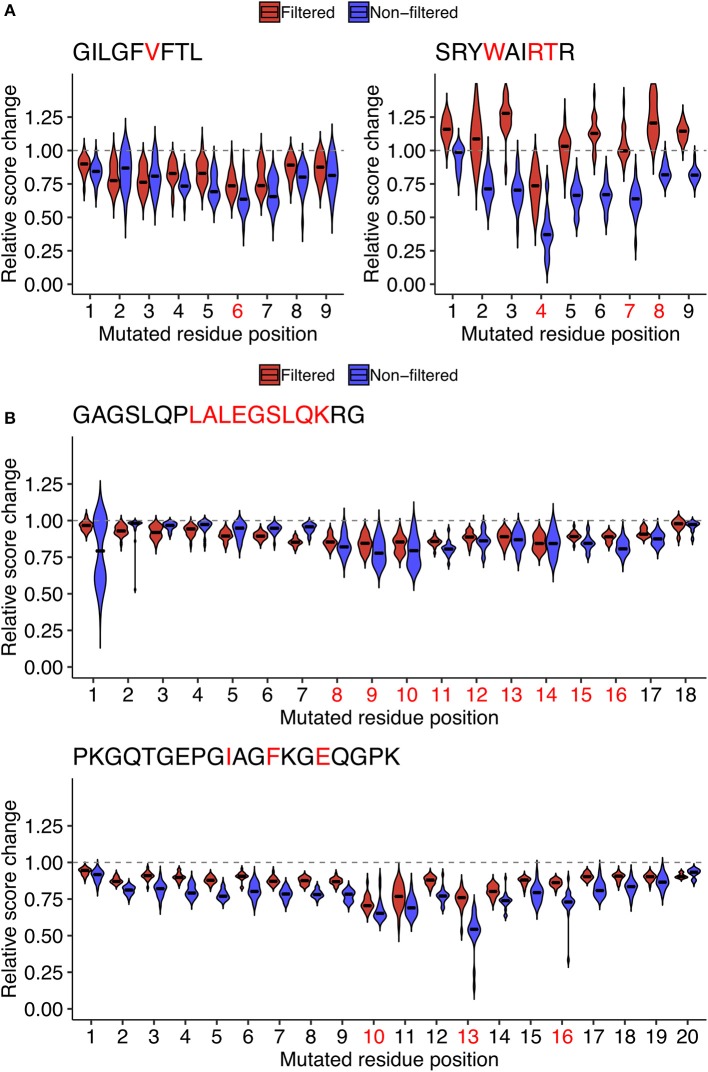
Assessment of the potential impact of overfitting for estimating the position-specific escape potentials. To test if the observed patterns of score dynamics originated from overfitting during the machine learning, for representative (A) MHC-I and (B) MHC-II peptides shown in Figure 6, probabilistic estimates of immunogenicity were re-computed without using any of the data of the single amino acid variants of the target peptide during machine learning (Red). The scores with no filteration were shown for comparison (Blue). See the legend of Figure 6 for further information.